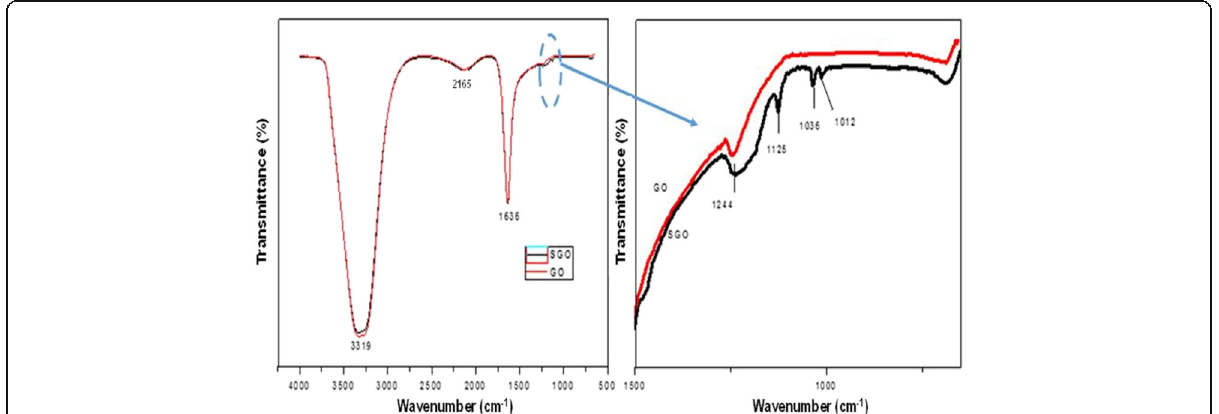
Fig. 1 a , b FTIR spectra for graphene oxide (GO) and sulfonated graphene oxide (SGO)